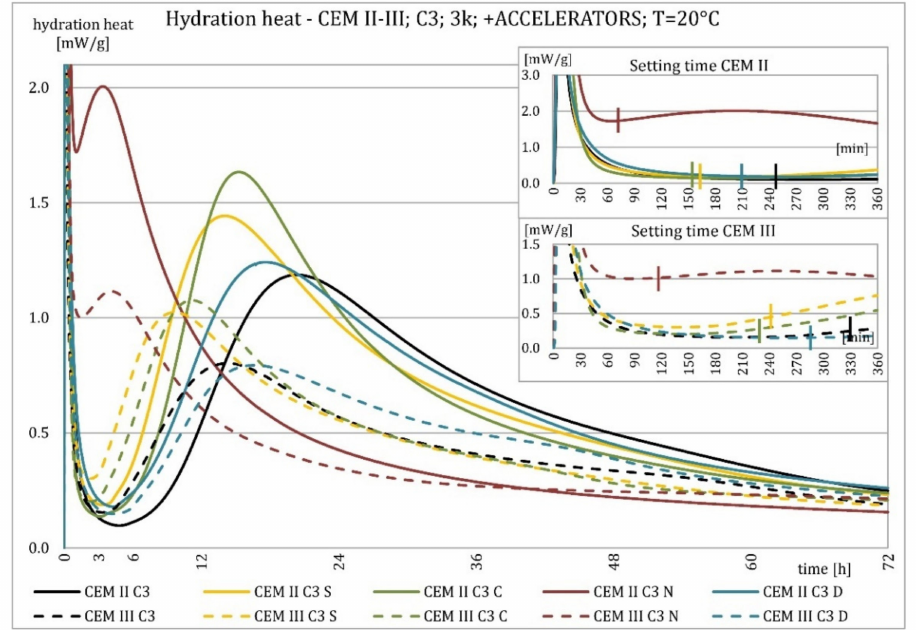
Figure 24. Hydration heat of C3 clinker-based cements CEM II/B-S, CEM III/A modified with accelerators at 20 ◦ C.